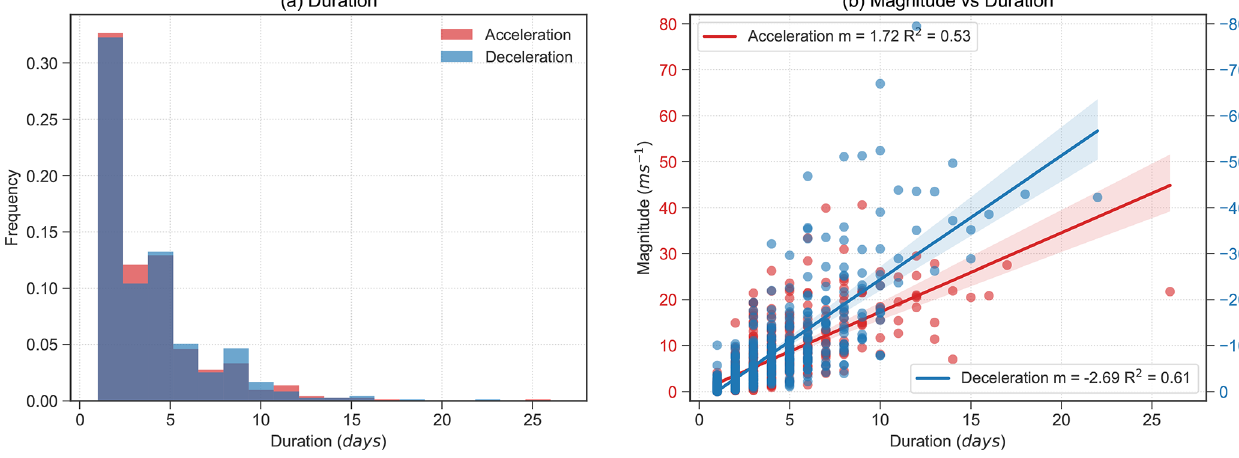
Figure A1. Periods of wind acceleration (red) and deceleration (blue) in reanalysis. (a) Duration and (b) the relationship between the magnitude and duration of the wind acceleration and deceler- ation periods. For acceleration periods (red), refer to the red axis on the left. For deceleration periods (blue), refer to the blue axis on the right. The solid lines mark the linear fit to the scatter plots, and the shading marks the 95% confidence interval of the fit. The histograms are normalised.